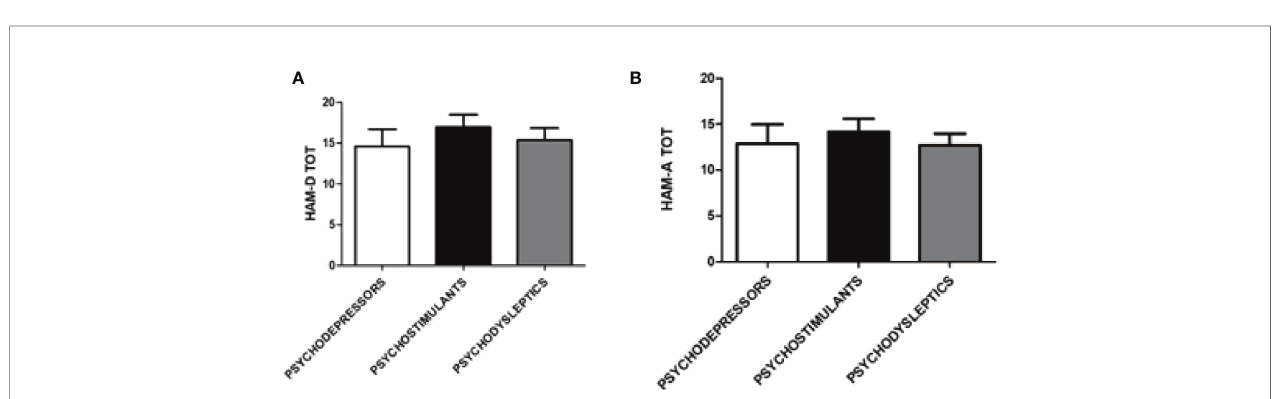
FIGURE 3 | Hamilton Depression (HAM-D) and Anxiety (HAM-A total) scales scores according to categories of substances. (A) HAM-D scale score according to the following categories of substances: psychodepressors, psychostimulants, and psychodyslpetics. (B) HAM-A total scale score according to the following categories of substances: psychodepressors, psychostimulants, and psychodyslpetics.